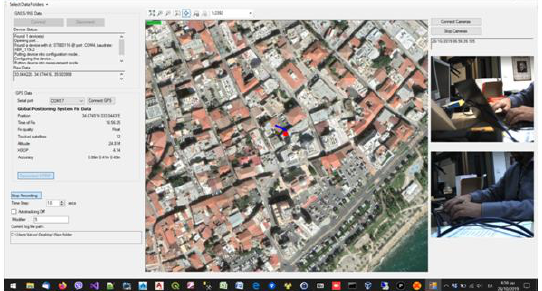
Figure 6: Example screen of data collection software